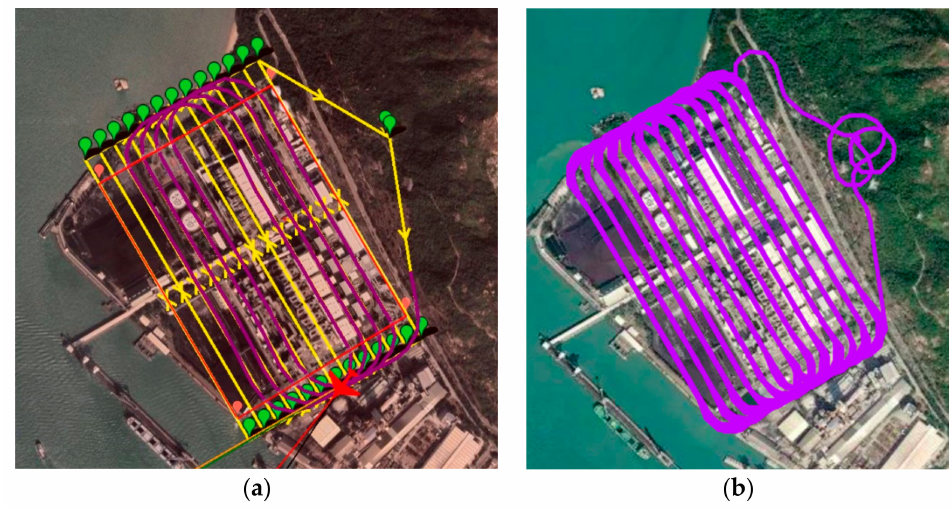
Figure 19. Bird’s eye view of the final trajectory result of circling-forward path in simulation platform 1 ( a ) and platform 2 ( b ).